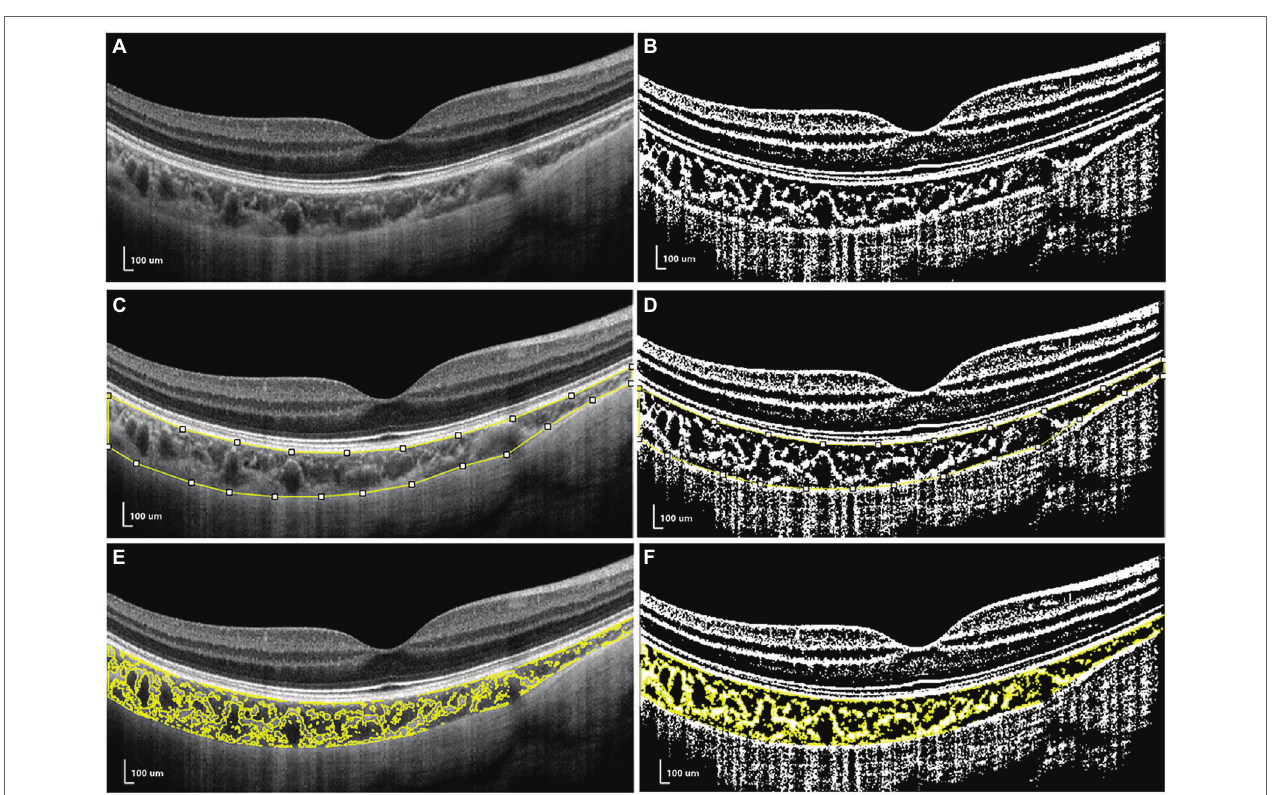
FIGURE 2 | The measurements of choroidal vascularity (CV). (A,C,E) the structural optical coherence tomography (OCT) image. (B,D,F) the binarized OCT